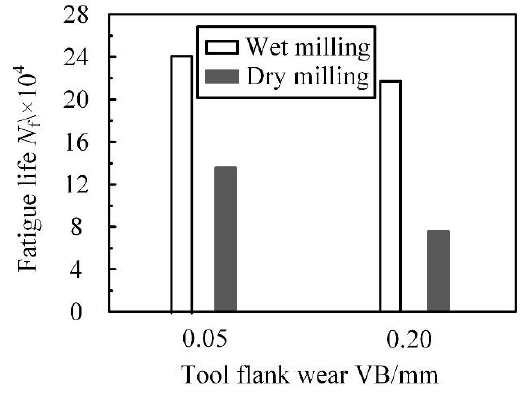
Figure 10. Fatigue life of milled specimens of the GH4169 superalloy with different cooling conditions.